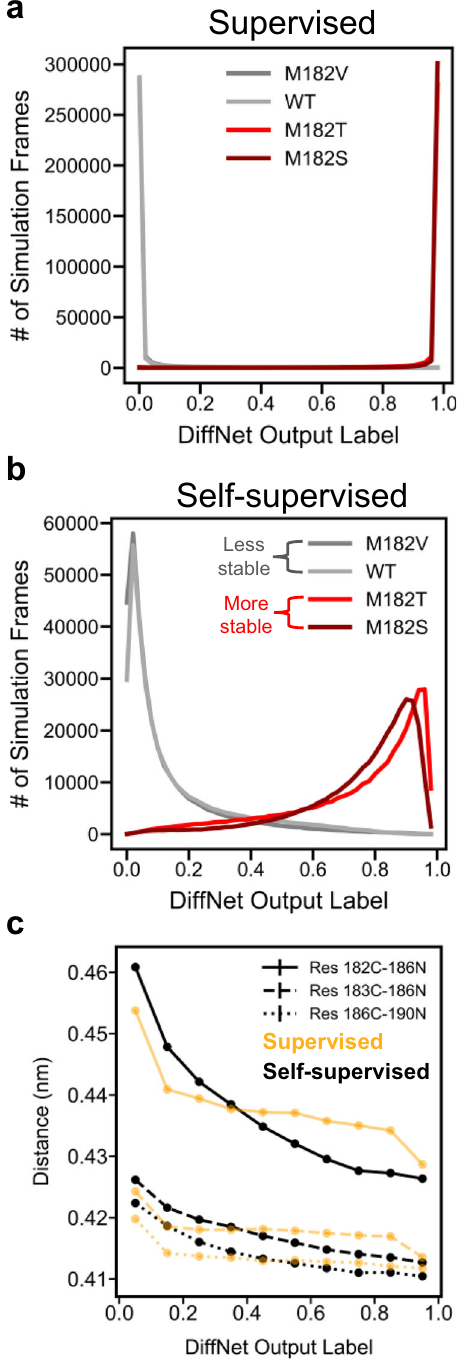
Fig. 5 Self-supervision improves the DiffNet ’ s ability to organize structural con fi gurations based on their biochemical property. Histogram showing DiffNet output labels across all simulation frames from M182T and M182S (red – highly stable variants in training set) versus WT and M182V (gray – less stable variants in training set) for a supervised autoencoder ( a ) and a self-supervised autoencoder ( b ). c Three key hydrogen bond lengths in helix 9 as a function of the DiffNet output label ( n = 1,300,420) (yellow – supervised, black – self-supervised), which ranges from zero for structures associated with low stability to one for structures associated with high stability. The distances are between the carbonyl carbon of the i th residue and the nitrogen of the ( i + 4)th residue. Standard error bars are not visible since the standard error is smaller than scatter